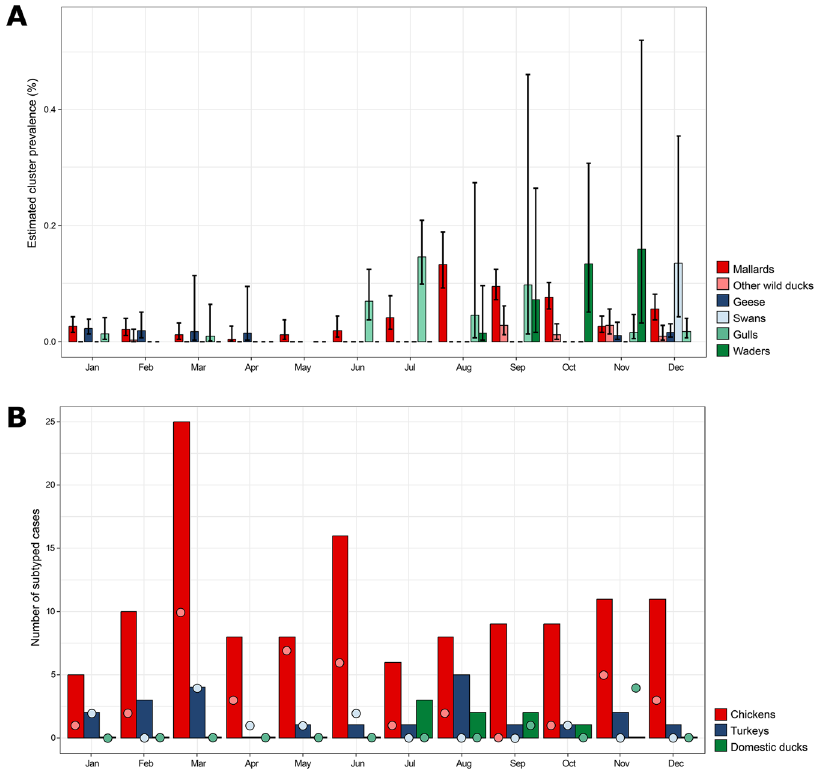
Figure 5. Temporal patterns of virus detections in wild birds and poultry. ( A ) Estimated cluster prevalence of low pathogenic avian influenza (LPAI) viruses in wild birds per month of the year. For this analysis, subtyped cases in wild birds were clustered based on identical host species, subtype combination, sampling location and collection date. The error bars show the standard deviation between different years. ( B ) Number of subtyped cases in poultry per month of the year based on serology (bars) and virology (dots). The black line represents the average number of poultry farms tested per month of the year. The error bars show the standard